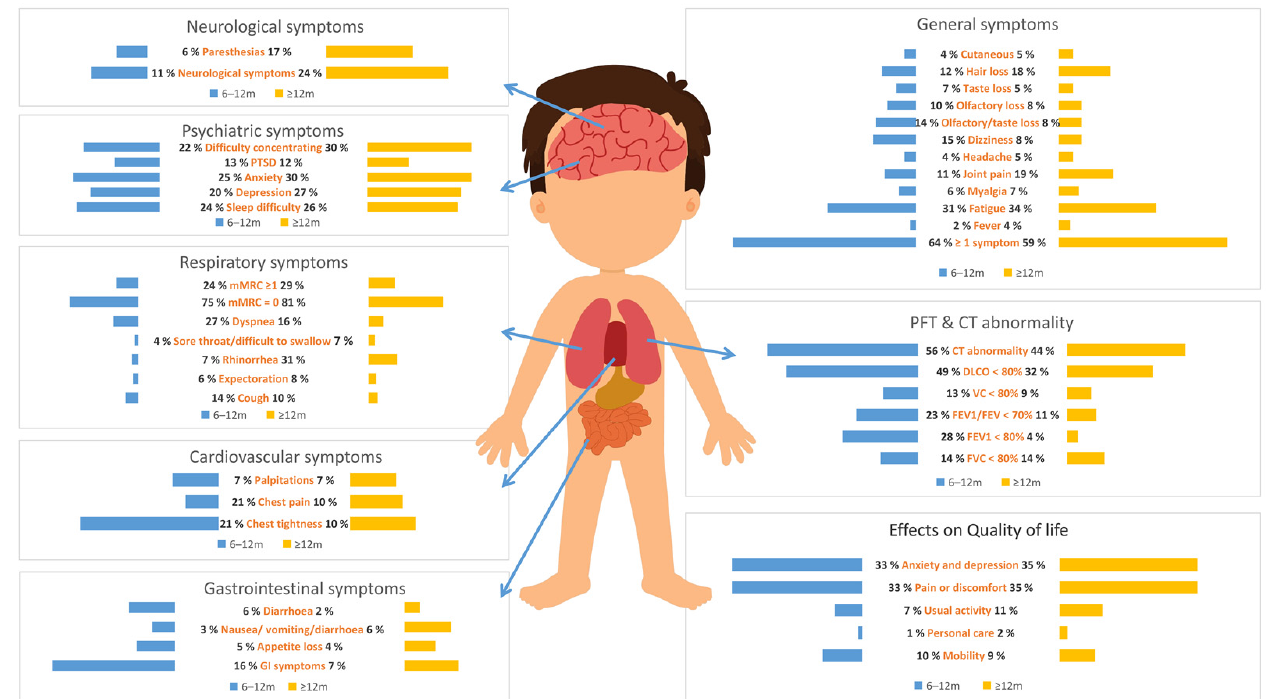
Figure 2. Pooled prevalence of COVID-19 consequences at 6 months and above.